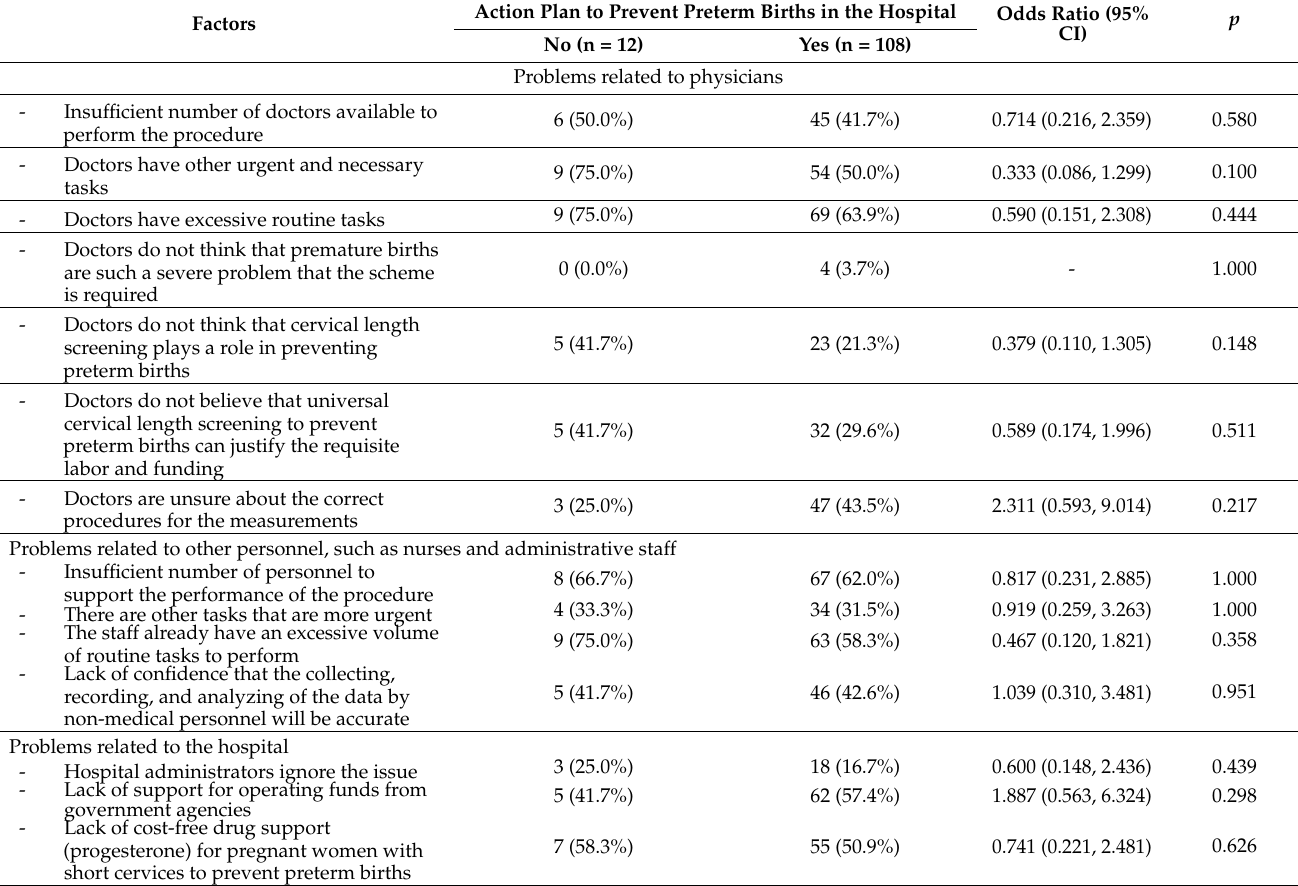
Table 4. Factors associated with an action plan for preventing preterm births in the hospital.